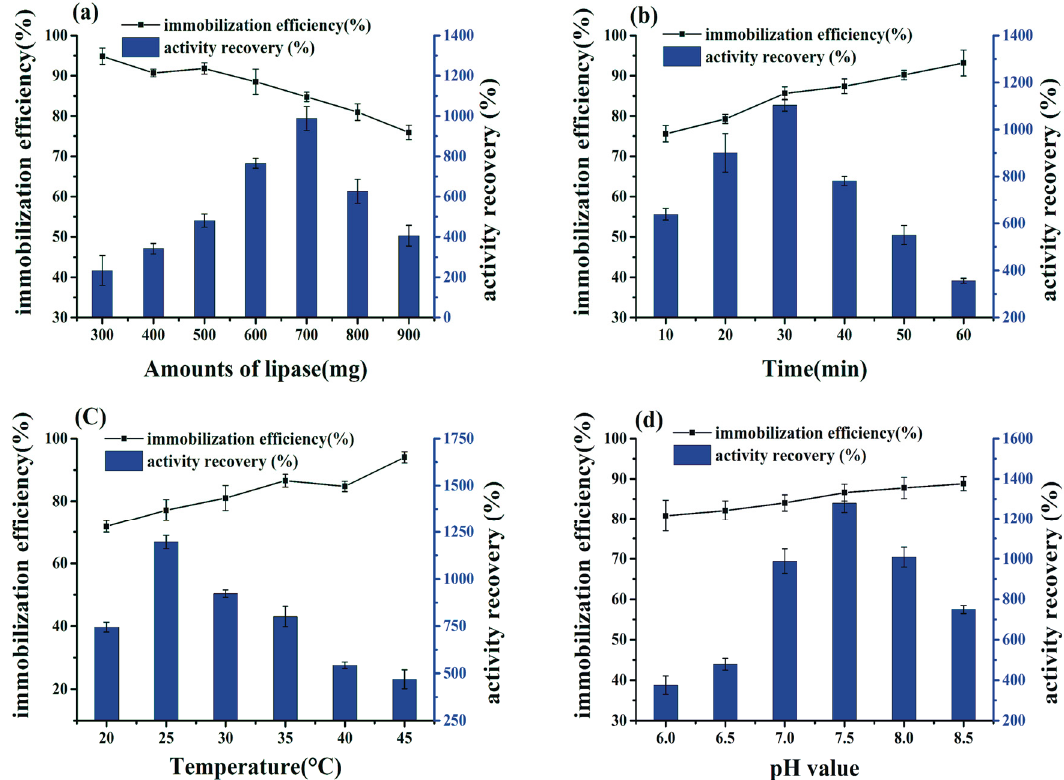
Figure 6. Influence of various immobilization conditions on immobilization efficiency and activity recovery. ( a ) Amounts of lipase; ( b ) adsorption time; ( c ) reaction temperature; ( d ) pH value.